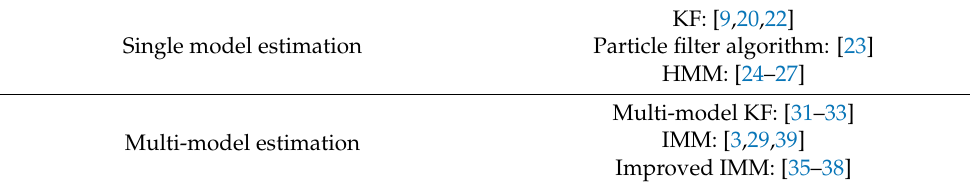
Table 1. Overview of state estimation model